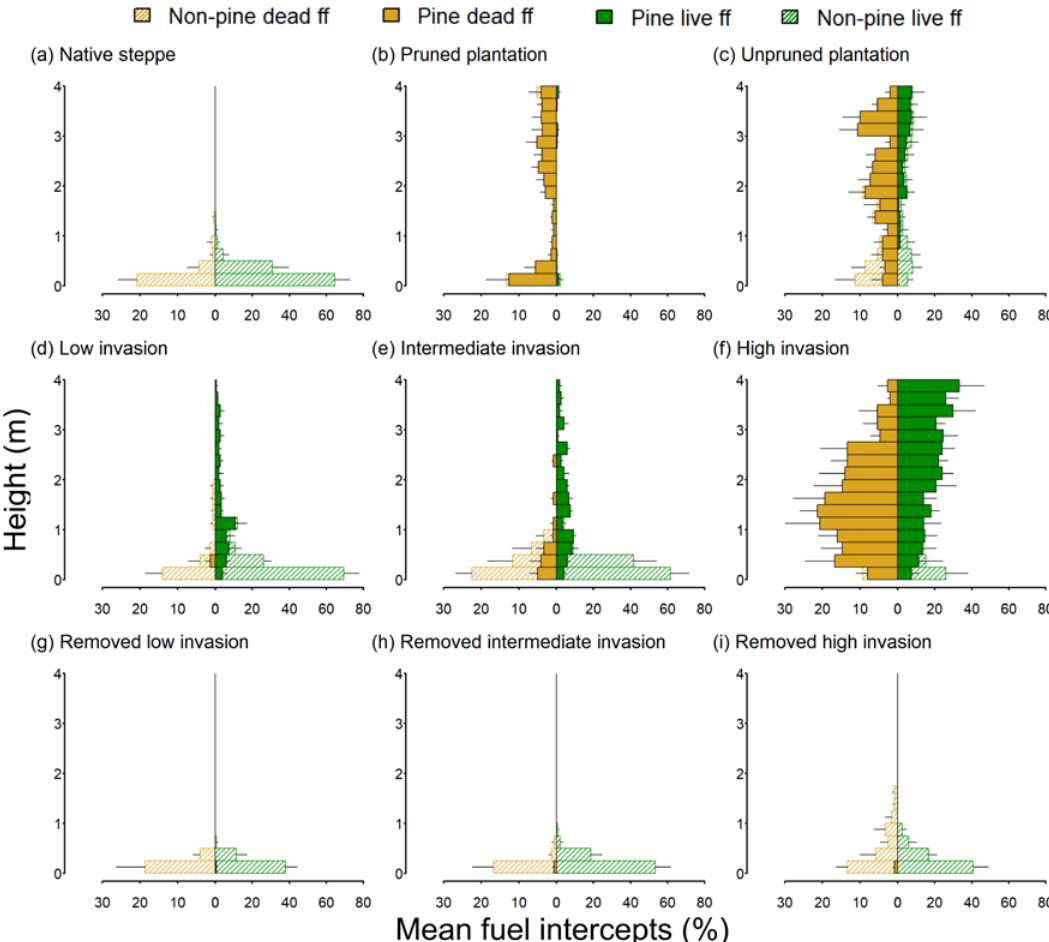
Figure 1. Vertical distribution of the mean fuel intercepts (±SE) at each of the nine treatments divided into 0.25 m height classes: native steppe ( a ), pruned plantation ( b ), unpruned plantation ( c ), low invasion level ( d ), intermediate invasion level ( e ), high invasion level ( f ), removed low level invasion ( g ), removed intermediate level invasion ( h ), and removed high level invasion ( i ). Bars represent mean dead and live fine fuel (ff) intercepts classified into pine and all fuels together.